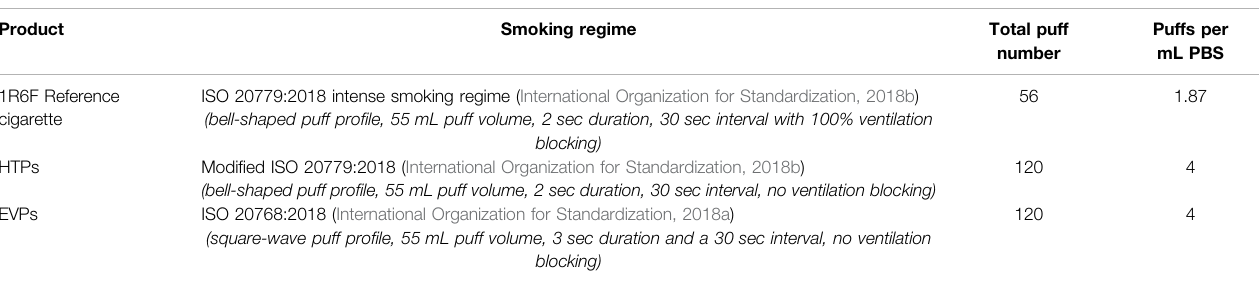
TABLE 2 | Smoke/aerosol generation standardized